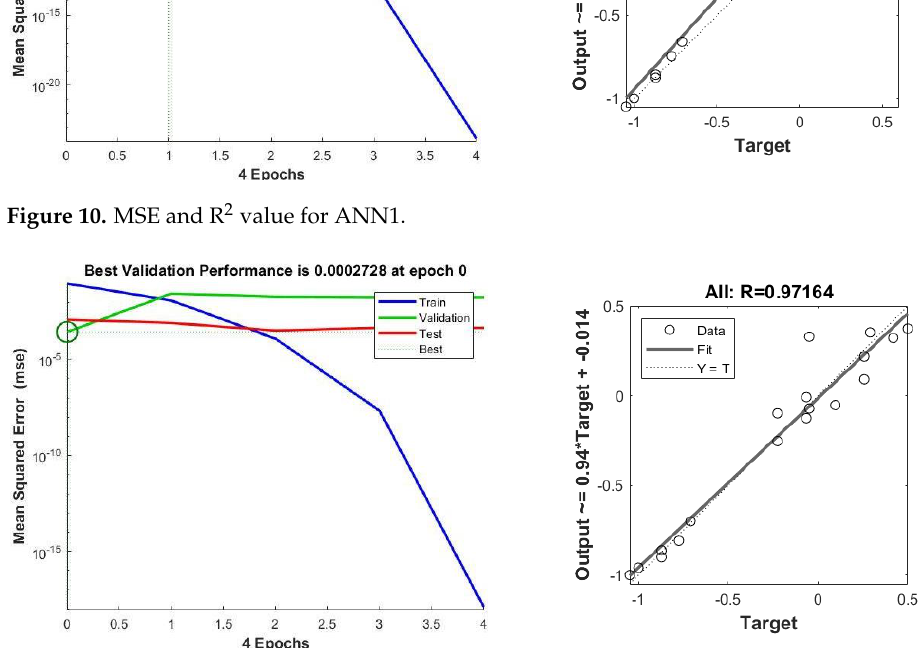
Figure 11. MSE and R 2 value for ANN2.